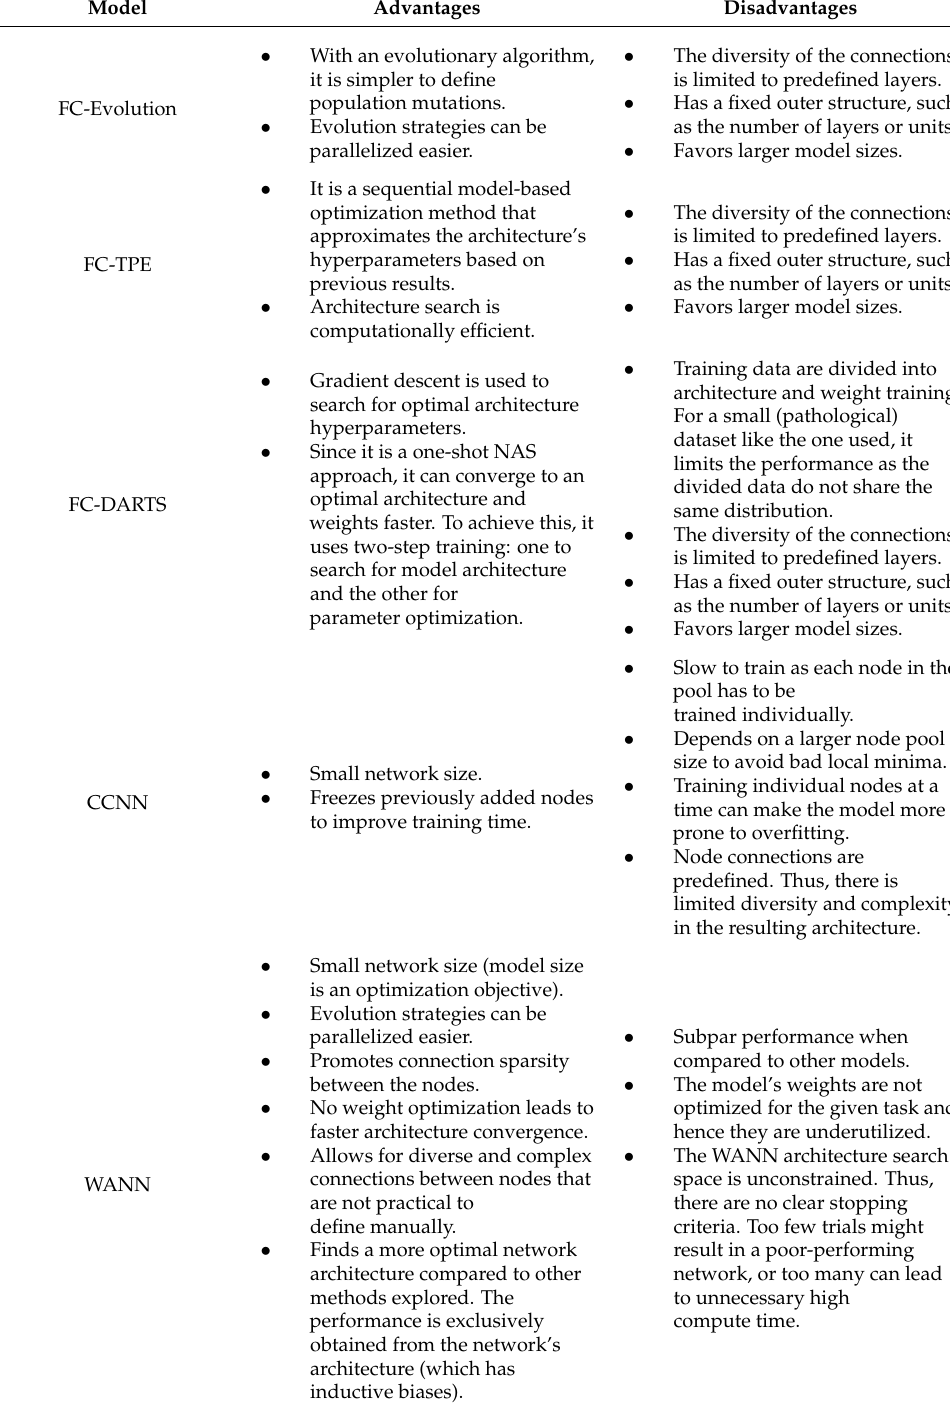
Table 6. Summary of the main advantages and disadvantages of the models